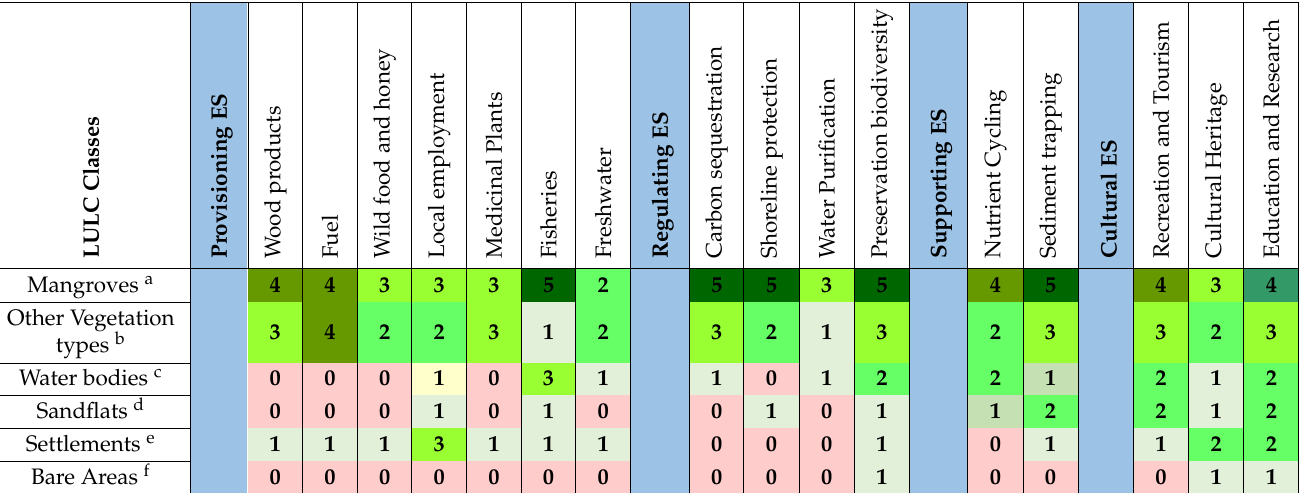
Table 2. Matrix for the assessment of the different LULC classes’ capacities to supply selected ES in Ungwana bay, Kenya. The assessment scale 0 = rosy colour (no flow), 1 = grey-green (very low flow), 2 = light green (low flow), 3 = peridot green (medium flow), 4 = tarragon green (high flow), and 5 = dark green (very high